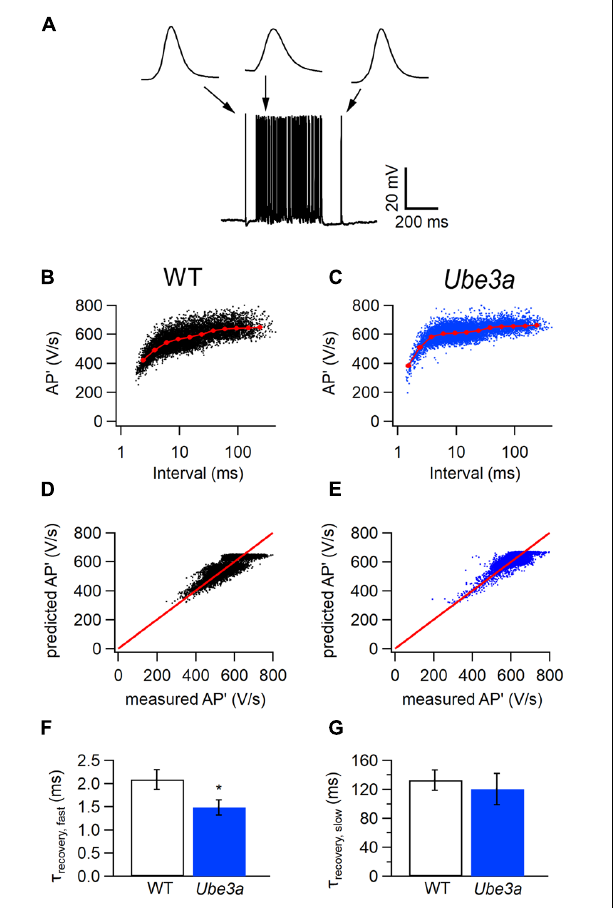
FIGURE 6 | Faster recovery from AP depression in Ube3a mice. Recordings were made in the juxtacellular (loose-patch) configuration. (A) Increase in spike frequency during a 400 ms, 80 dB noise burst (solid line). Insets are three juxtacellular complex waveforms before, during and after the sound stimulation at higher time resolution. (B,C) Relation between the maximal amplitudes of the first derivative of the eAP and the interspike interval in a cell from a C57BL/6J WT (B) and a cell from a Ube3a E113X mouse (C) . Red line indicates the binned average of the values predicted by the resource depletion model. (D,E) Relation between eAP’ predicted by the model and measured eAP’ for the data shown in D and E , respectively. (F) Comparison of the fast recovery time constant from eAP depression in C57BL/6J WT and Ube3a E113X mice. ∗ Indicates p < 0.05. (G) Comparison of the slow recovery time constant from eAP depression in C57BL/6J WT and Ube3a E113X mice.